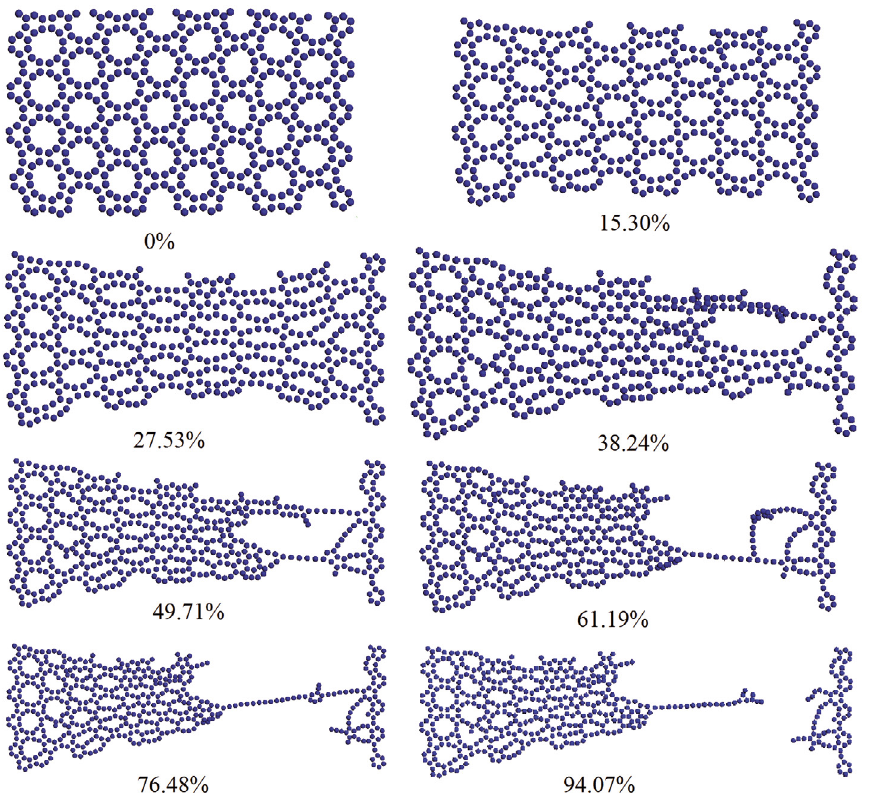
Figure 7: The shapes of a 30×50 Å 2 armchair graphenylene at different